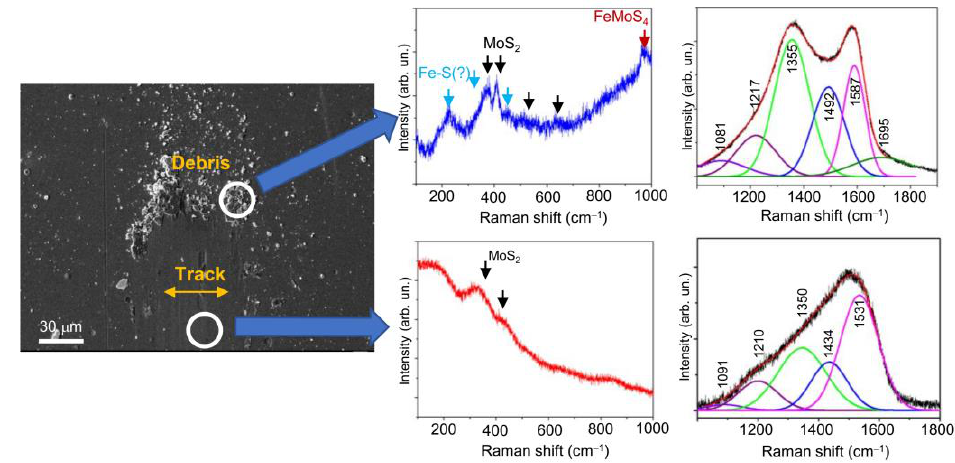
Figure 15. SEM image and Raman spectra for the Mo-S-C-H_5.5 thin-film coating subjected to pin-on-disk test at 22 ◦ C in dry friction conditions (RH